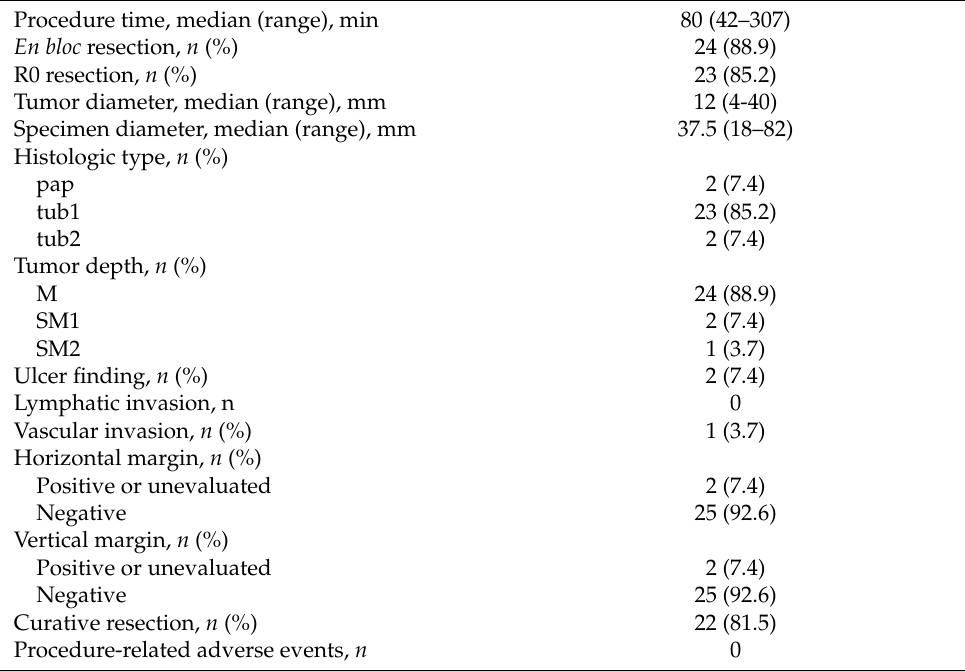
Table 3. Treatment results of endoscopic submucosal dissection ( n = 27).